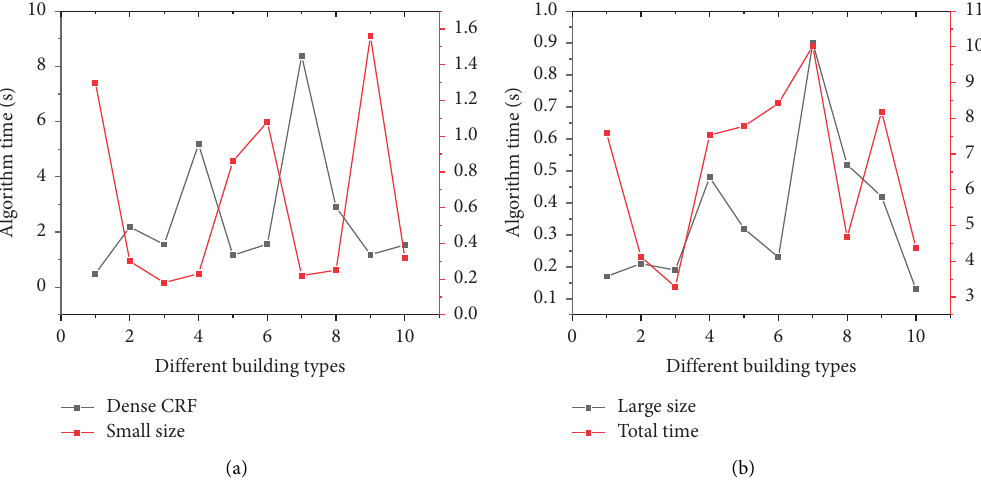
Figure 10: Building outline estimation results.